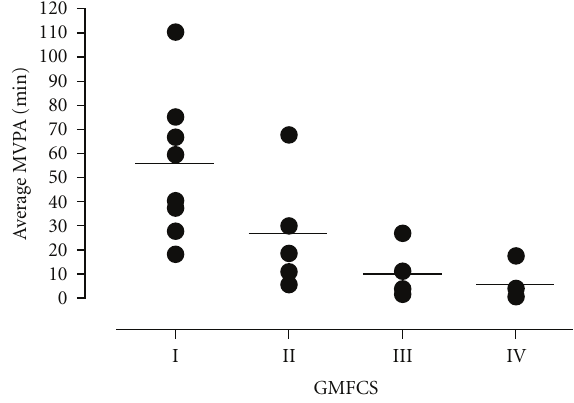
Figure 2: Moderate-to-vigorous activity time in adolescents with CP by GMFCS level. MVPA: moderate-to-vigorous physical activ- ity; CP: cerebral palsy; GMFCS: Gross Motor Function Classifica- tion System; min: